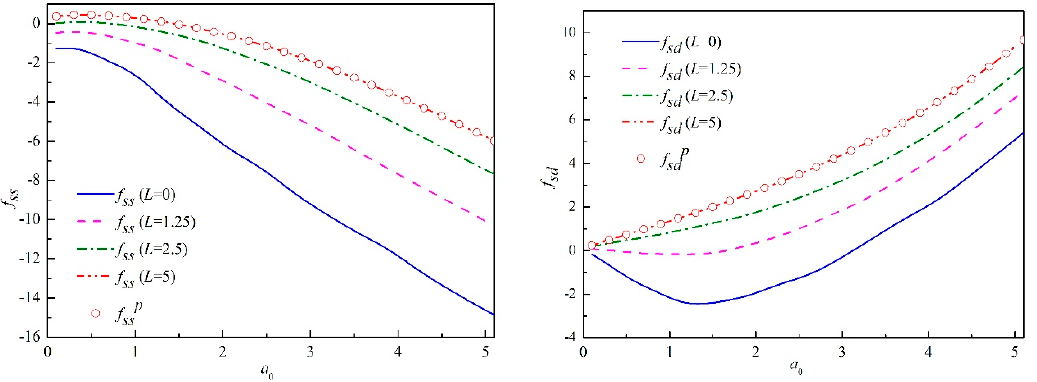
Figure 3. Verification of the foundation side.